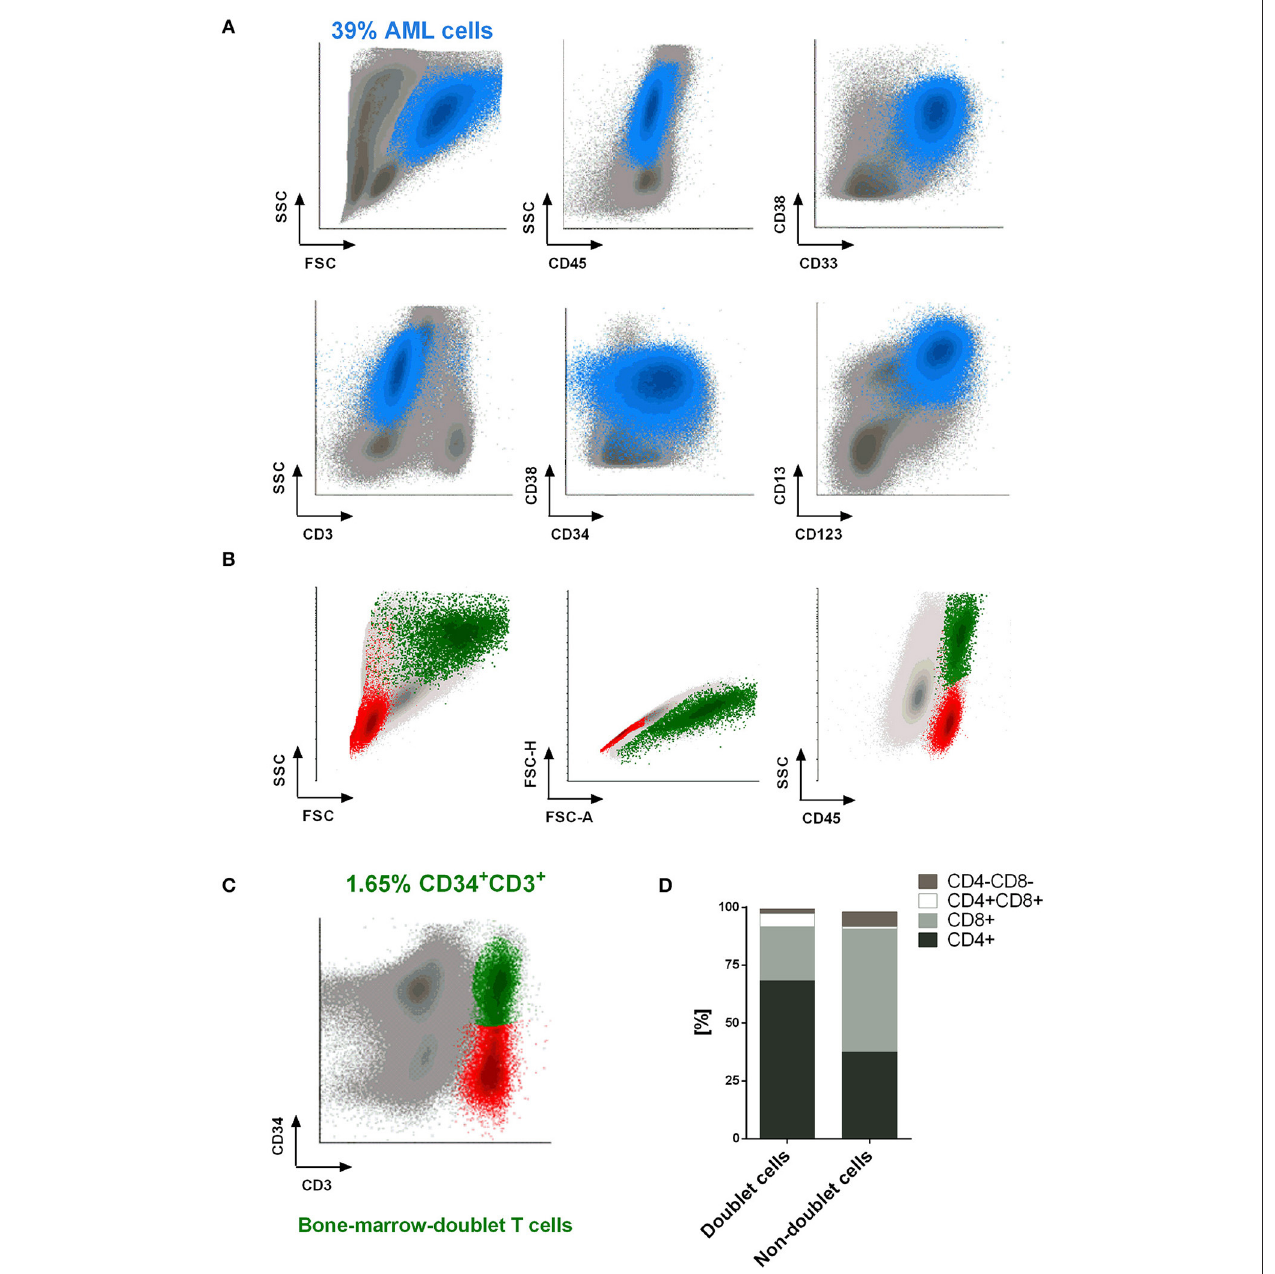
FIGURE 7 | Doublet-forming T cells from bone marrow of AML patients. (A) Blast cells from bone marrow of an AML patient are shown. The immunophenotype of AML cells was: CD45low CD34 + CD117 + CD33 + CD38 + CD123 + CD13 + /– (blue population). (B,C) T cells from bone marrow of an AML patient at diagnose were co-incubated with AML cells. Doublet-forming T cells were identified based on their FSC/SSC, doublet zone FSC-A/FSC-H distribution as well as their positivity for CD45 and both CD3 and CD34 (CD3 + CD34 + ; green population). Non-doublet T cells were also identify as control (CD3 + CD34–; red population); one representative case is shown. (D) Percentage of CD4 + , CD8 + , CD4 + /CD8 + , and CD4–/CD8– cells in bone marrow-doublet T cells compared to bone marrow-non-doublet T cells. Data show mean values of three independent